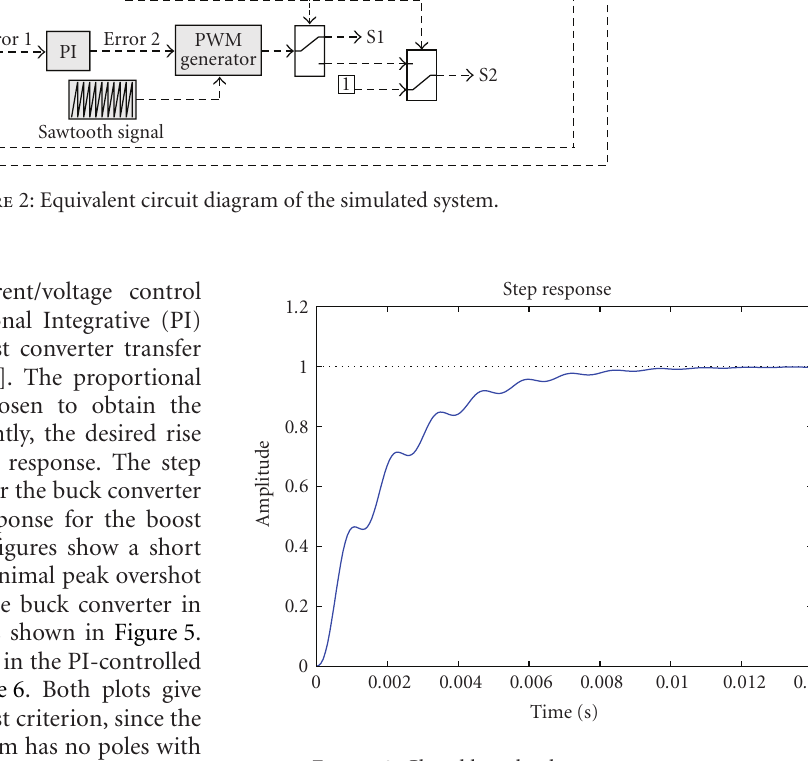
Figure 3: Closed loop buck converter step response.